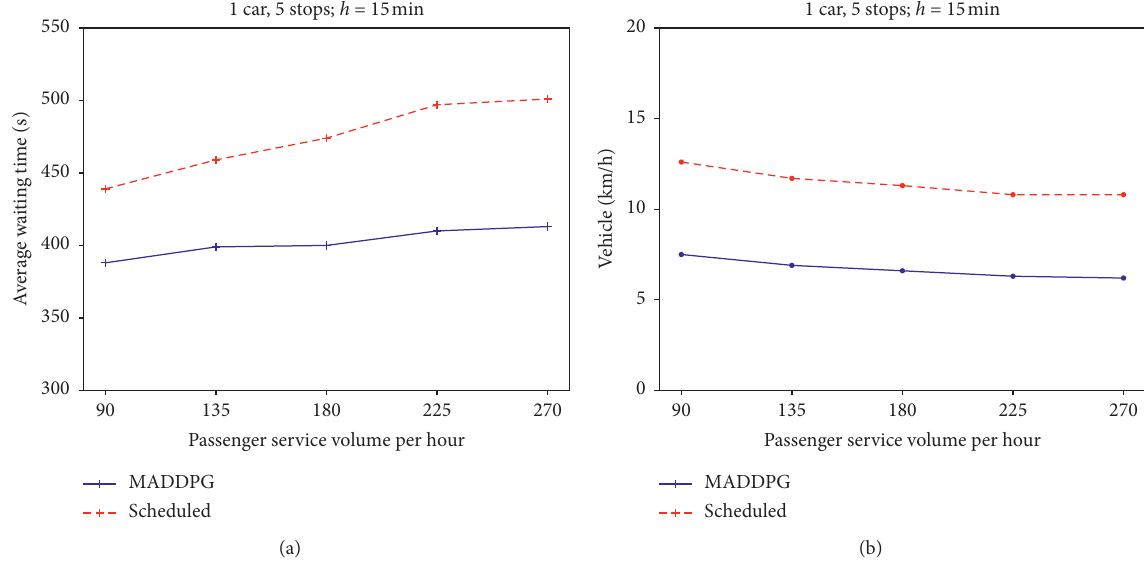
Figure 7: Performance comparison between the MADDPG and SCHEDULED methods in Scenario 1 based on the average passenger wait time and VKH.